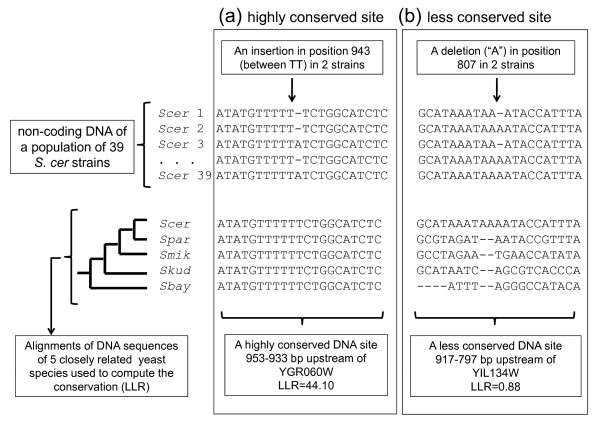
Computation of the LLR score for indels in the non-coding DNA. Once the indel is detected in population (here 39 S. cerevisiae yeast strains depicted in the top panel), an alignment of width W = 21 of orthologous sequences (referred to as the DNA site) from 5 closely related yeast species (including the reference S. cer, S. paradoxus, S. mikatae, S. kudriavzevii, and S. bayanus) is made centred around the position of the indel (bottom panel). The conservation of the DNA site is measured through the LLR score by measuring the relative rate of evolution of the site compared to the synonymous rate of evolution of the protein's coding region. (a) shows an insertion that falls into a highly conserved DNA site whereas (b) shows a deletion that falls into a region that is not conserved.